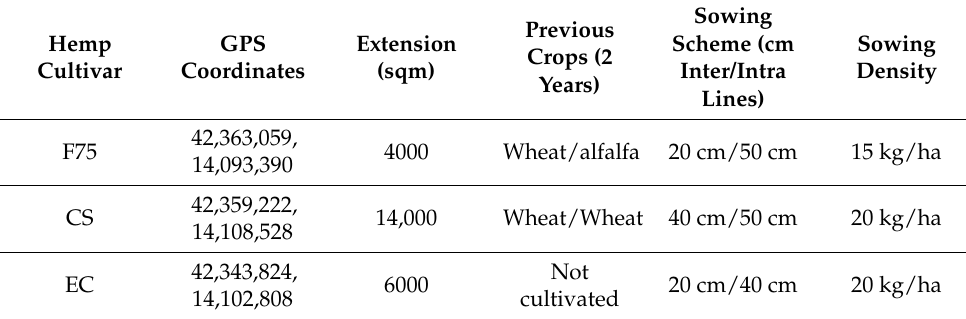
Table 1. Characteristics of the experimental